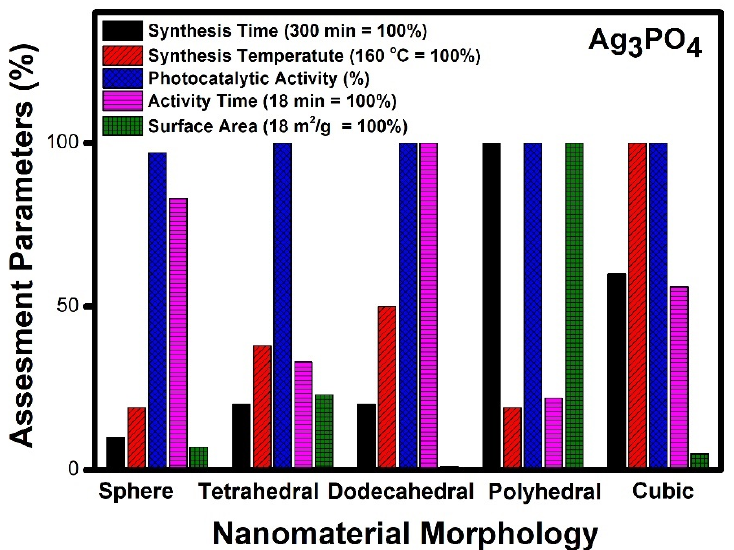
Figure 8. Comparative study of different morphologies of Ag 3 PO 4 based on various assessment pa- rameters.